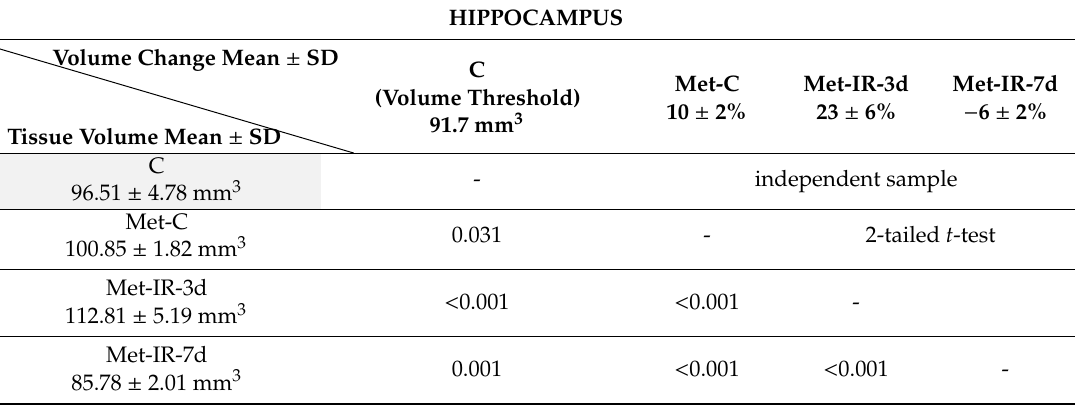
Table 2. MRI volumetry in the hippocampus of ischemized and non-ischemized animals. Tissue volumetric values (mean ± SD; orange background) of the hippocampus for naïve control (C, n = 8), Met-C ( n = 8), Met-IR-3d ( n = 5), Met-IR-7d ( n = 5) group of animals. Using independent-samples 2-tailed di ff erences in metabolite ratios between groups (grey background). Displayed is hippocampal normal volume threshold (C and percentages of tissue volume change (mean ± SD; blue background) in Met-C, Met-IR-3d, and Met-IR-7d groups with respect to the normal volume threshold in the